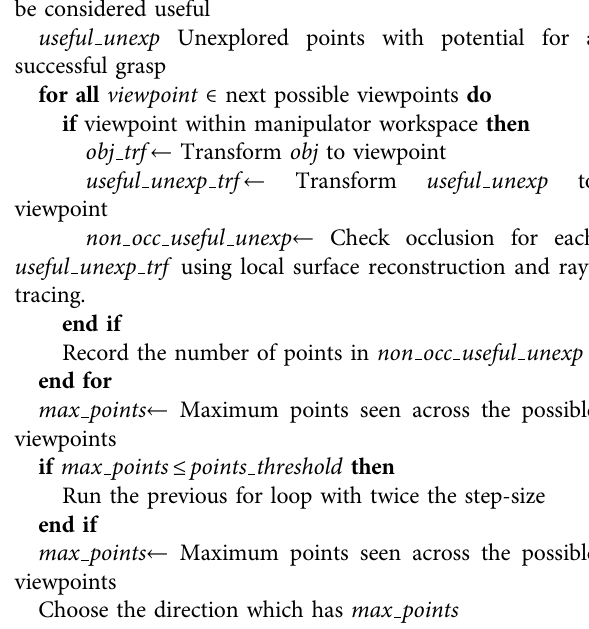
Algorithm 4: 3D Heuristic policy.